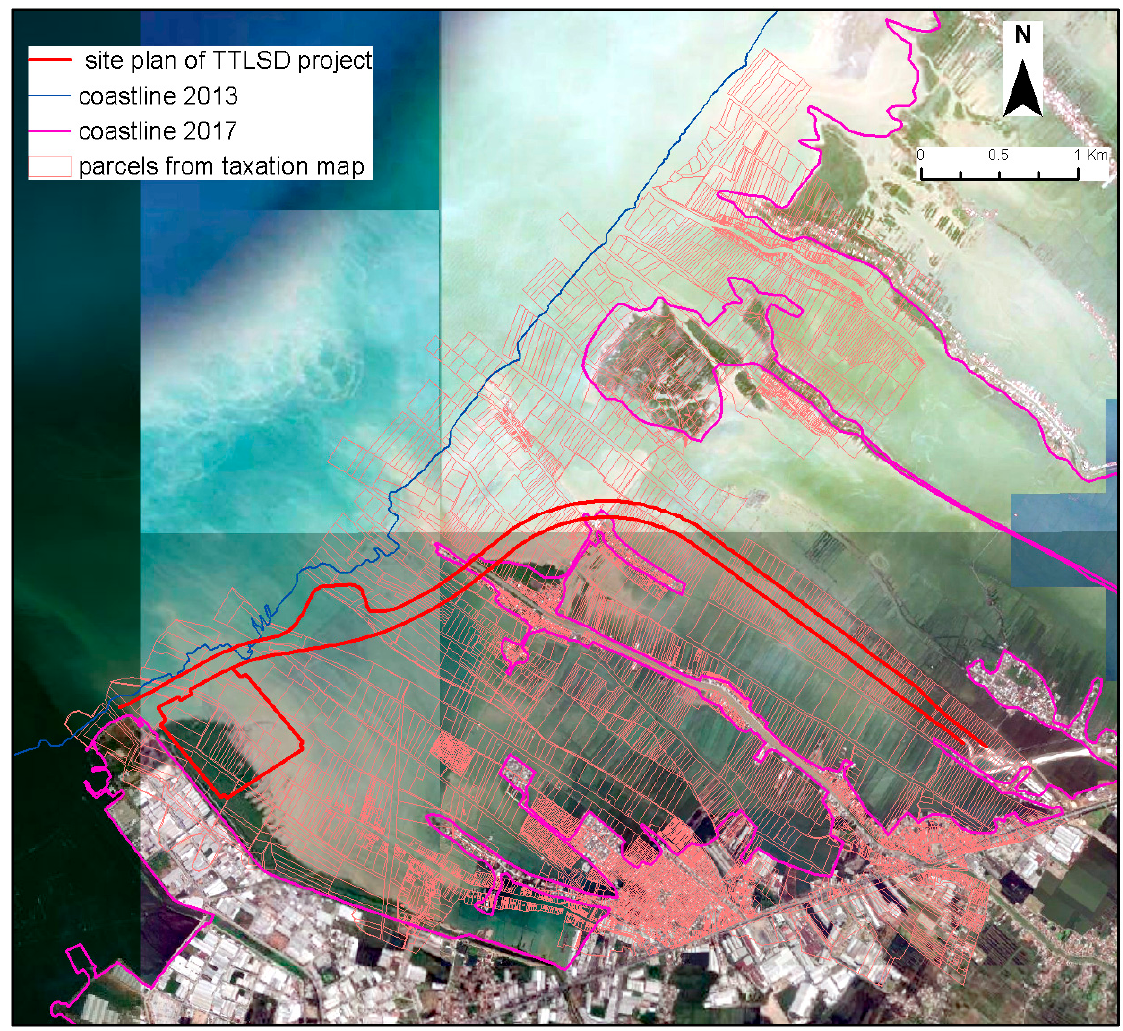
Figure 8. Site map of TTLSD project. The planned location is depicted in red line.